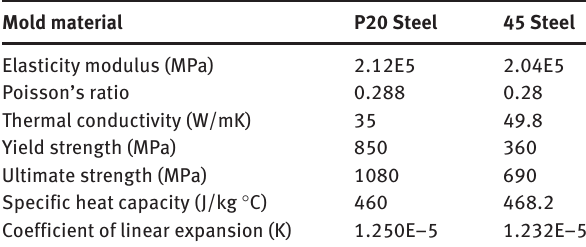
Table 3: Basic properties of the part’s mold